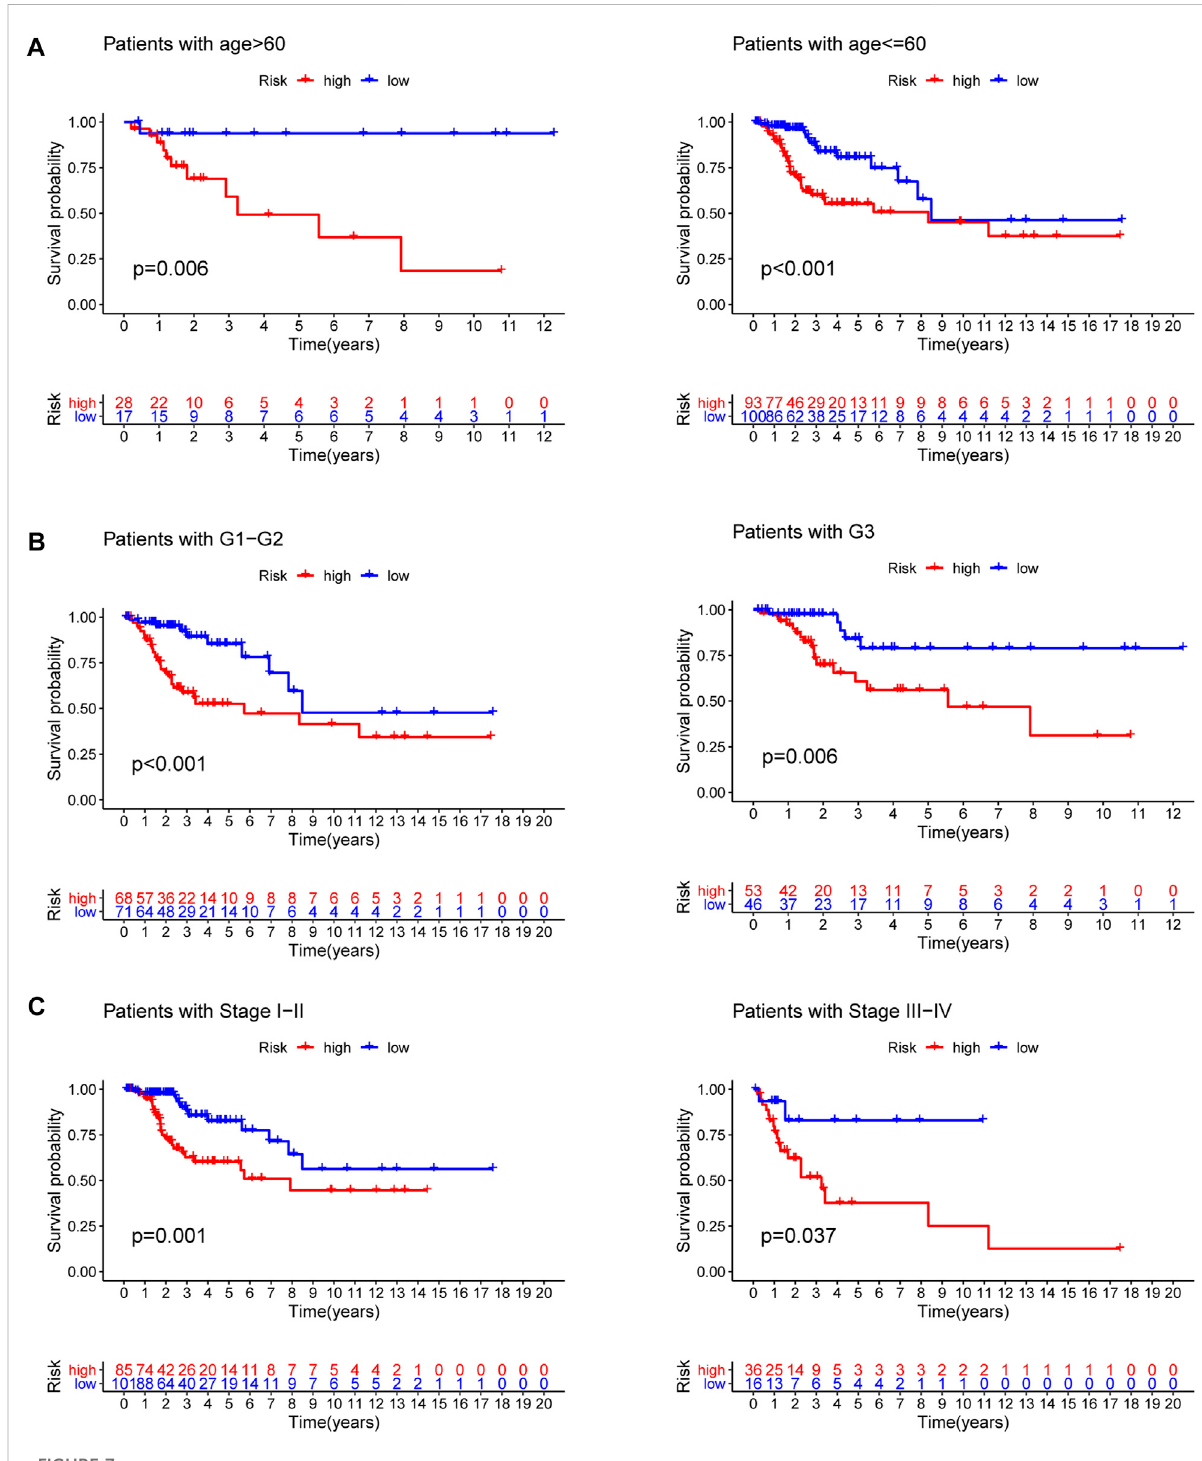
FIGURE 7 Subgroup survival analysis. (A) Age subgroup. (B) Grade subgroup. (C) Stage